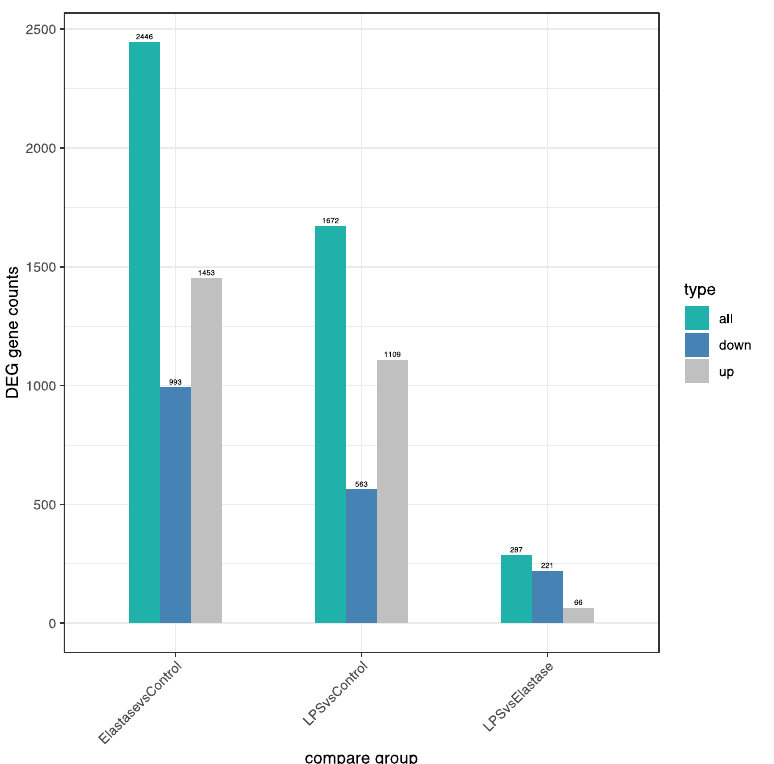
Figure 3. Number of significantly differentially regulated genes (DEG) either upregulated or down- regulated by treatments. Elastase upregulated approximately 30% more genes than LPS and down- regulated approximately 75% more genes than LPS. Overall, elastase differently regulated more genes than LPS.